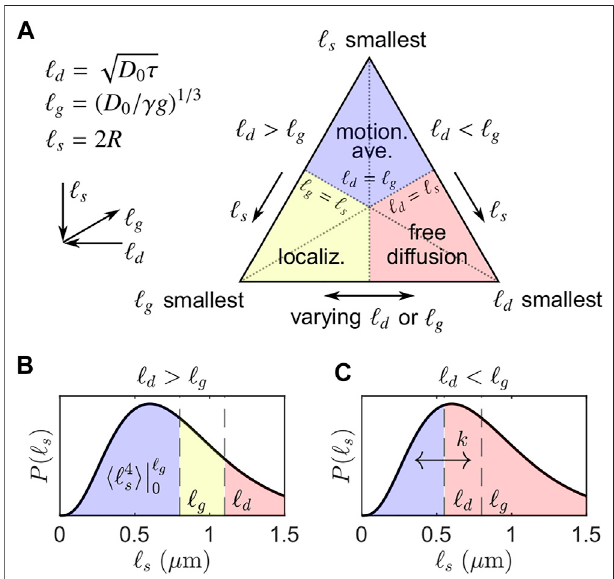
FIGURE 1 | Simpli fi ed visualization of signal regimes adapted from Moutal and Grebenkov [44]. (A) The three asymptotic regimes of signal behavior determined by the smallest of the three length scales: ℓ d , ℓ g , ℓ s . (B) Regimes when ℓ d > ℓ g and ℓ g = 0.8 μ m, corresponding to the left side of the triangle in (A) . A representative distribution of ℓ s with PDF P ( ℓ s ) is shown. For ℓ s > ℓ d , diffusion remains approximately free. Note that the signal decay of the motionally averaged signal fraction is not dependent on ℓ d and exhibits ensemble-averagedbehaviorover ℓ s =[0, ℓ g ],leadingtopersistentsignaleven for large ℓ d . (C) Regimes when ℓ d < ℓ g and ℓ g = 0.8 μ m, corresponding to the right side of the triangle in (A) . We conjecture that exchange with some fi rst- order exchange rate k may occur between restricted and free microenvironments encoded by non-Gaussian and Gaussian signal attenuation. The DEXSY experiment with ℓ d ≳ ℓ g takes advantage of the persistence of the non-Gaussian signal I / I 0 ∝ exp( − b 1/3 ) relative to the rapid attenuation of Gaussian signal I / I 0 ∝ exp( − b ) to maximize sensitivity to exchange between restricted and free